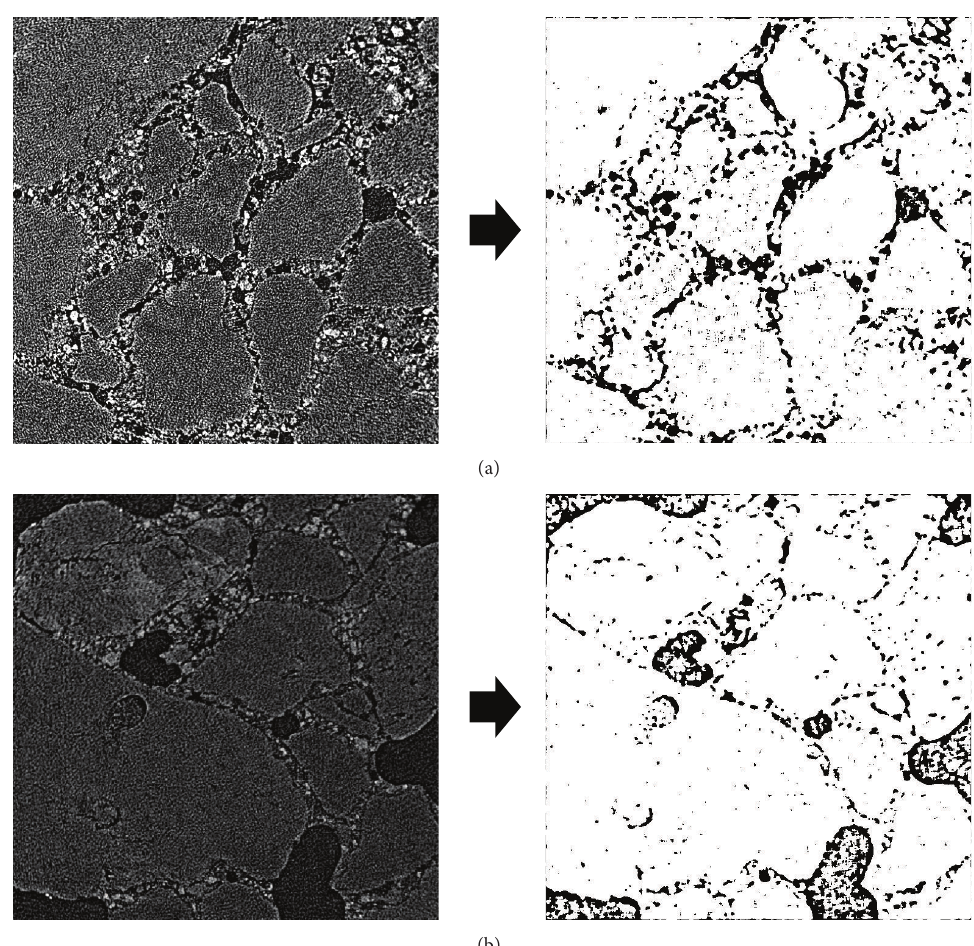
Figure 9: Cross-sectional images of the specimen with/without glass beads (left: 8-bit image, right: binary image (white: solid, black: void)): (a) image of insulating concrete specimen with glass beads, (b) image of concrete specimen without glass